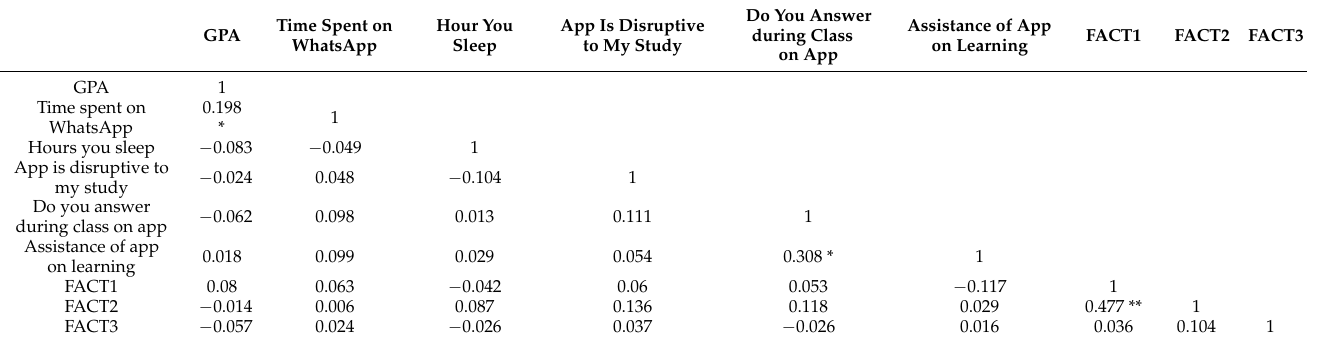
Table 6. Spearman correlation between the variables (correlation matrix) with WhatsApp Indian